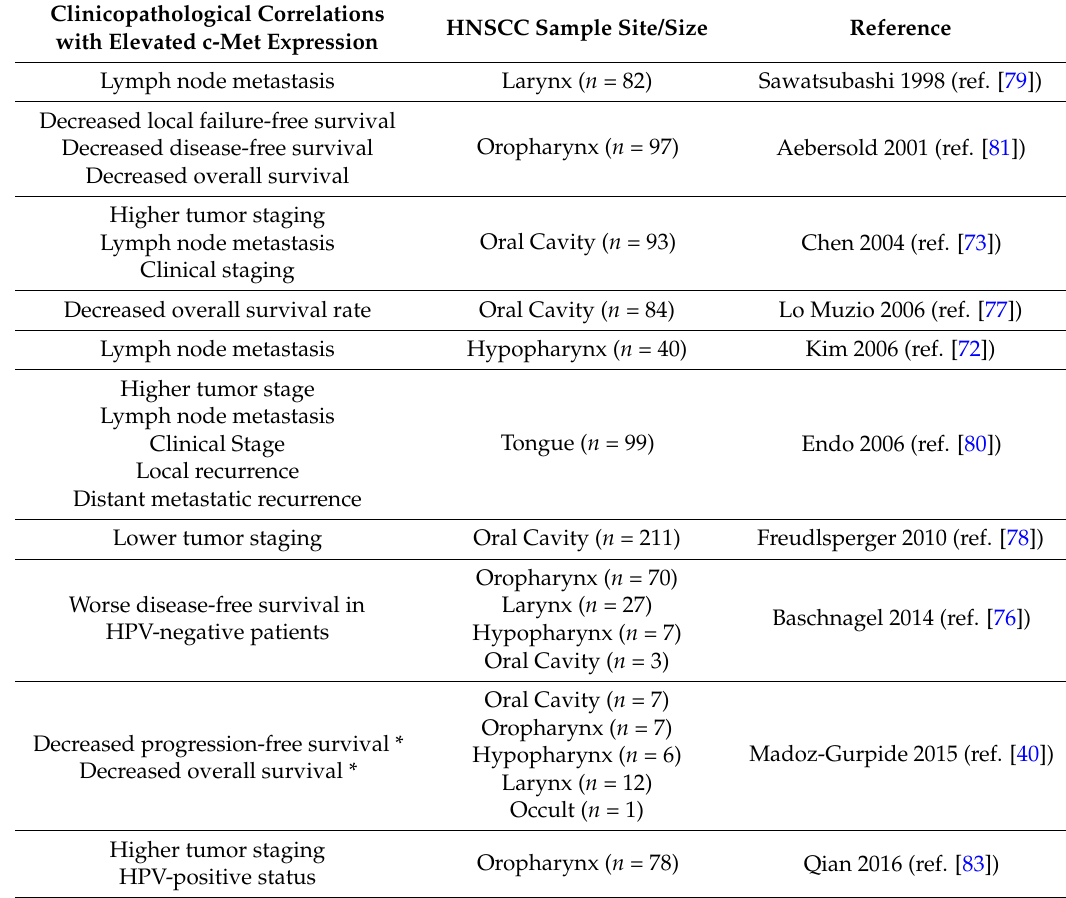
Table 1. Clinical Correlations with c-Met Expression in HNSCC